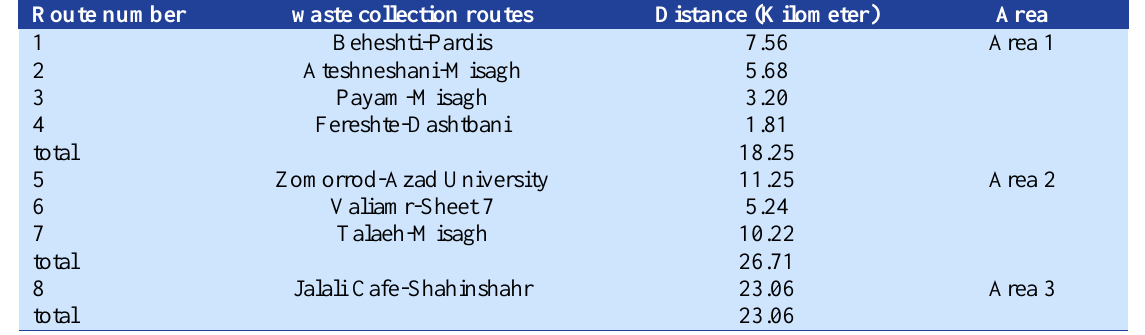
Table 2. Estimated distance from the collection point to the transfer station Route